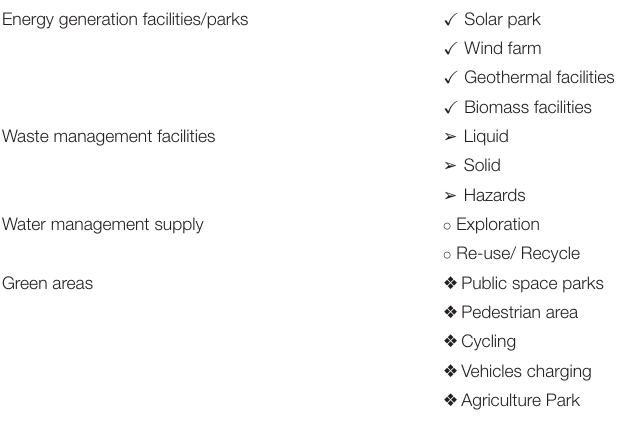
TABLE 1 | Key elements of airports’ environmental aspects. TABLE 2 | Key features of the reviewed seasonal airports in Mediterranean tourist